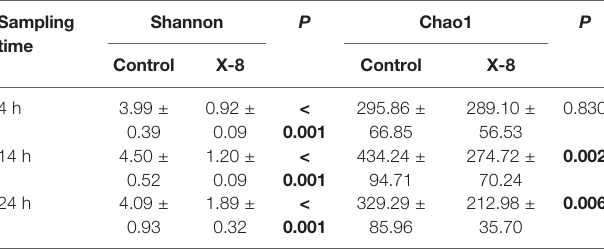
X-8, PpX-8infected group. Bold values indicate signi fi cant